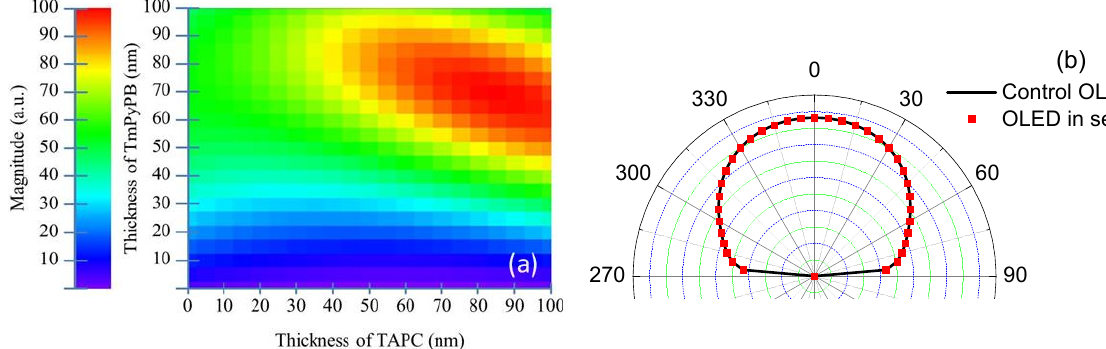
Figure 5. ( a ) The calculated normalized EL output of the control OLED and the OLED in the sensor, in the normal direction, as a function of the thickness of the TAPC hole transport layer and the TmPyPB electron transport layer. The color shown in the vertical bar in the plot indicates the magnitude of luminance (arb. unit); ( b ) The spatial emission profiles of the control OLED (solid line) and OLED unit (red square symbol) in the organic optical